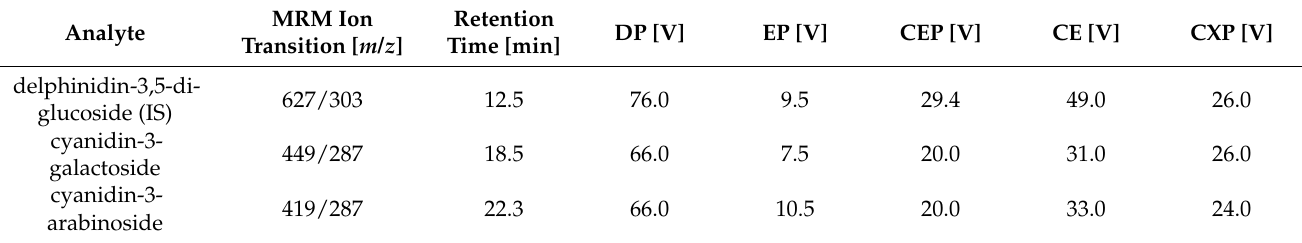
Table 7. HPLC-ESI-MS/MS (MRM) ion transitions [ m / z ], retention times [min], and substance- specific parameters (DP: declustering potential, EP: entrance potential, CEP: cell entrance